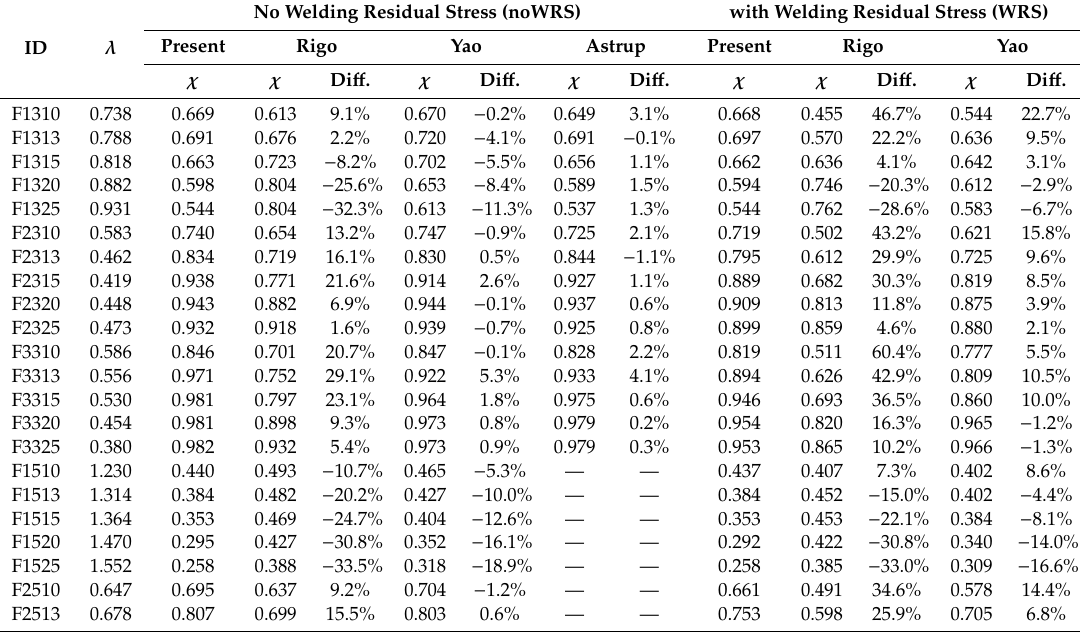
Table A1. Results obtained in the present study and in the ISSC’2000 benchmark calculations for the ultimate strength of flat-bar sti ff ened plates